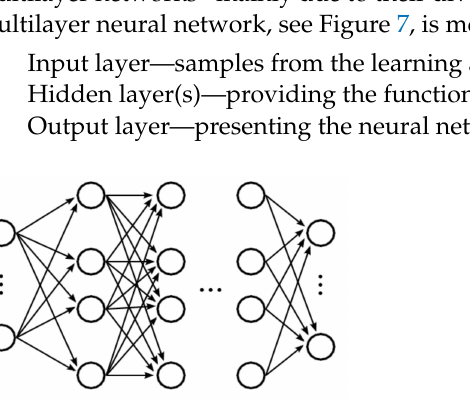
Figure 7. Example of forward neural